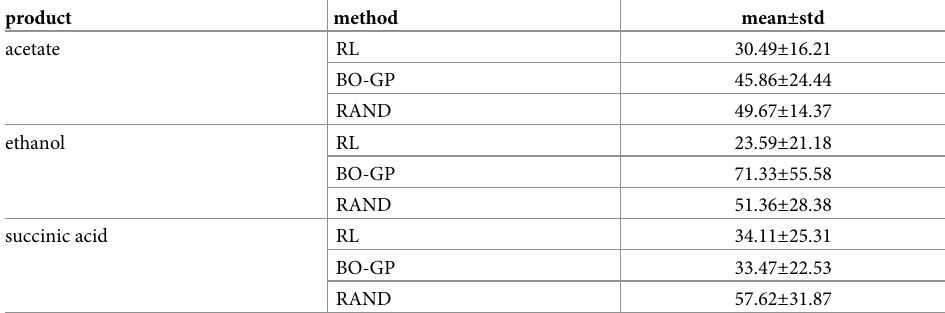
Table 2. Mean and standard deviations of the strain stability measure (RSD) obtained with algorithms. For each product and each method mean and standard deviation among 20 computed RSDs are